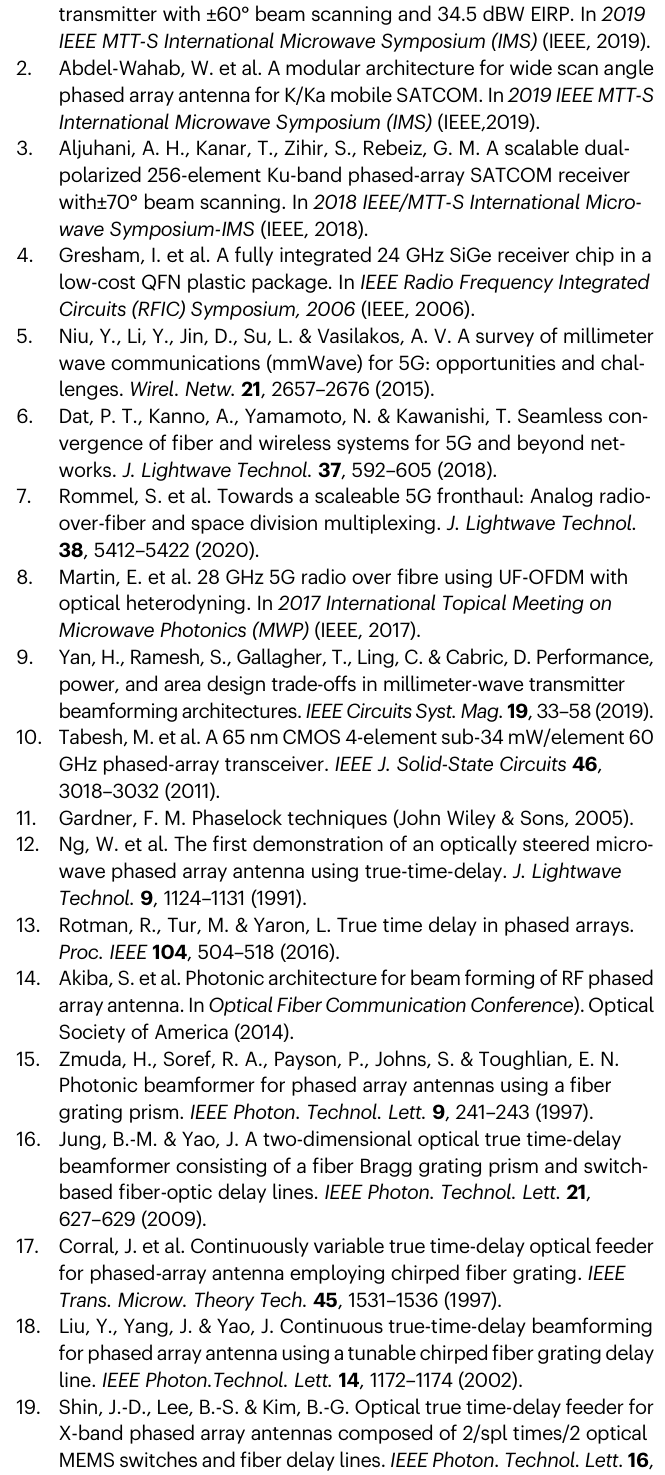
Figure 7aisthe measurement setup of anopticaland wirelesslink used to test the photonic-assisted phased array transmitter chip. A pattern generator modulated one of the laser signals with NRZ PRBS7 data using a 10 Gb/s optical intensity modulator. The modulated optical signal was then ampli fi ed to around 15dBm using an EDFA and